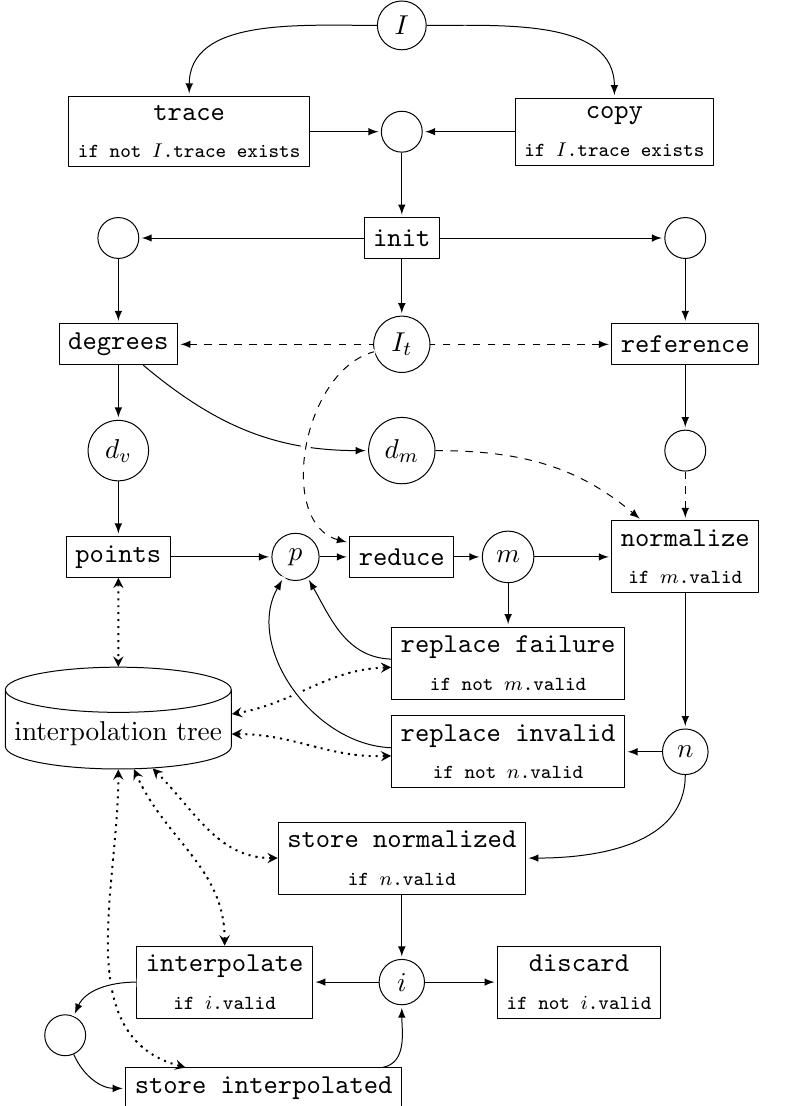
Figure 5 . The Petri net for row reduction via interpolation. A description of the syntax is given in the (cid:12)rst paragraph of section